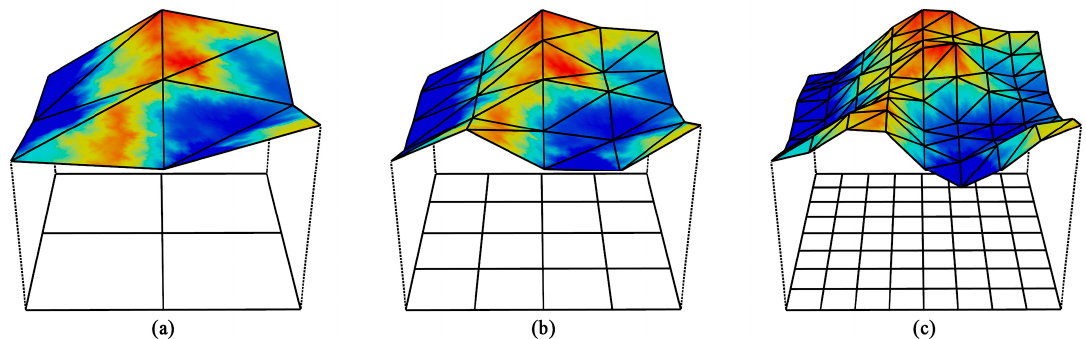
Figure 2. Illustration of popping artefacts caused by using several limited levels at power of 2: ( a ) Tessellation level = 2.0. ( b ) Tessellation level = 4.0. ( c ) Tessellation level = 8.0.